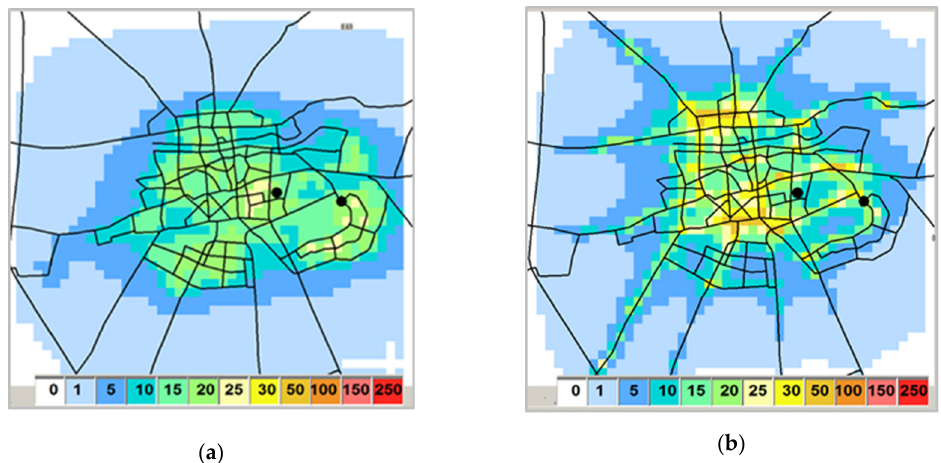
Figure 13. Monthly mean PM 10 concentrations ( µ gm − 3 ) in February 2019 simulated by LAQMS: ( a ) from household heating, ( b ) from traffic. The black dots indicate the two AQ stations.